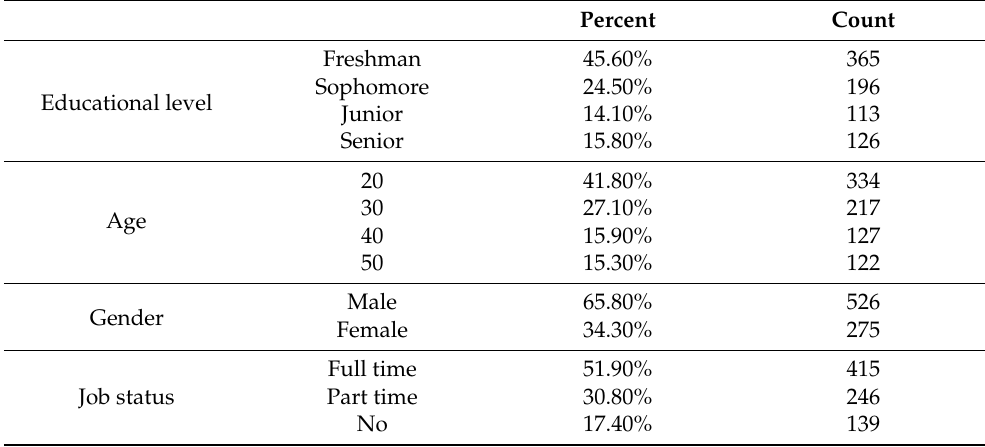
Table 1. Descriptive statistics of subjects.